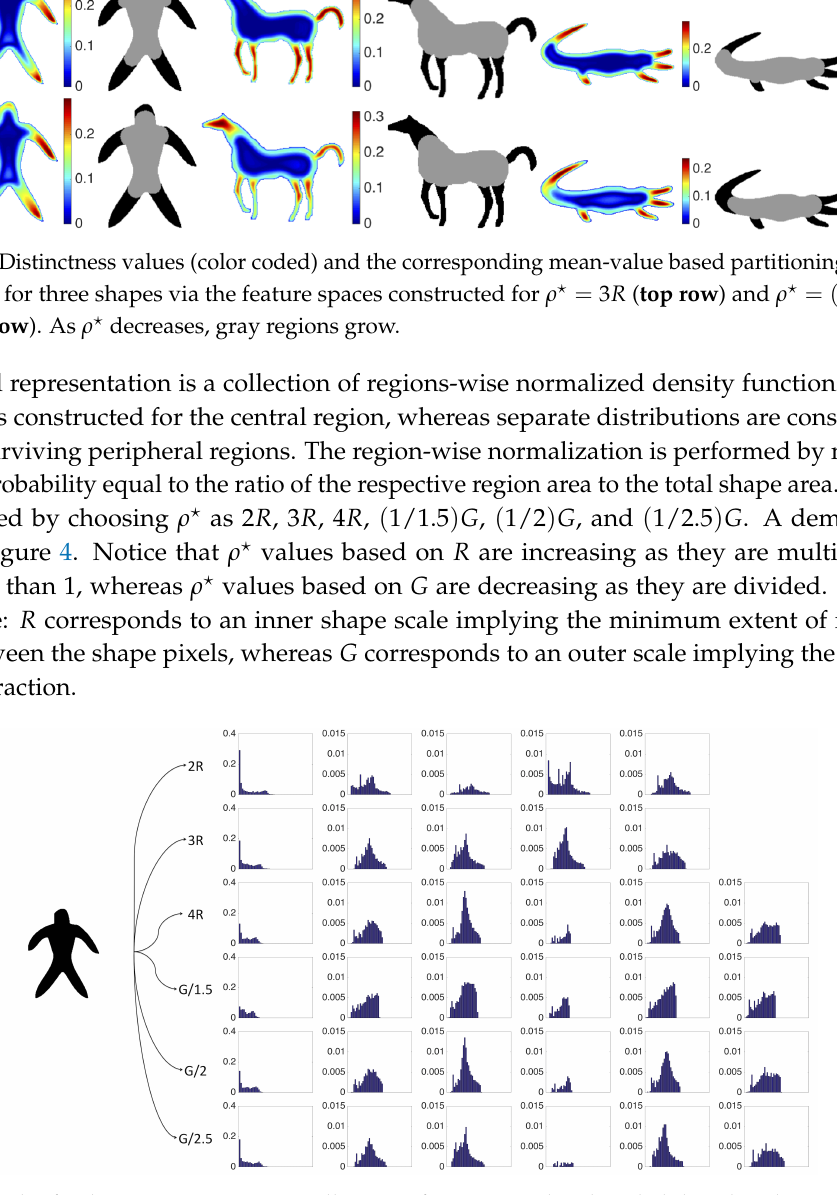
Figure 4. The final representation as a collection of size normalized probability distributions over regions over six scales. The first distribution at each scale describes the central region. There is no ordering between the remaining distributions describing the peripheral